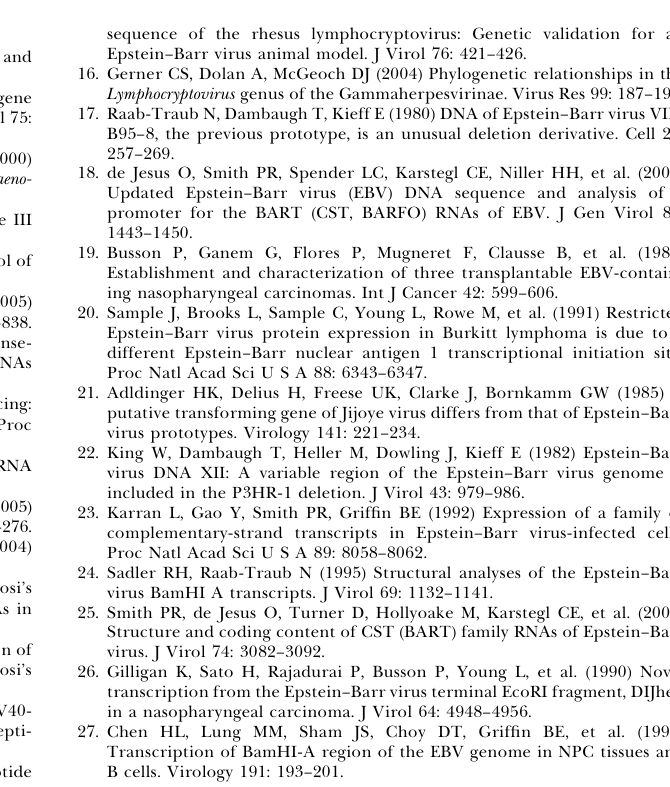
Figure S2. Northern Analysis of EBV miRNA Expression This analysis was performed as described in Figure 2, using total RNA samples derived from the indicated EBV-infected cell lines. U6 was used as a loading control. In the case of miR-BHRF1–2, we present a larger panel that shows both the mature 23-nt miRNA and the approximately 59-nt pre-miRNA. Figure S3. A Single Nucleotide Mutation May Disrupt miR-BHRF1–1 Processing in Jijoye Cells (A) Sequence comparison of the genomic region flanking the mature miR-BHRF1–1 sequence in the type II EBV present in Jijoye cells with the wild-type type I EBV sequence [18]. Two single nucleotide changes and the mature miR-BHRF1–1 sequences are highlighted in blue. (B) One of these single nucleotide changes is predicted to disrupt the base-pairing of the stem of the primary miR-BHRF1–1 precursor, as indicated. Figure S4. Immunofluorescent Detection of the EBV Zebra Protein Daudi and MUTU I cells were either cultured as normal or induced with TPA (30 ng/ml final concentration) and n-butyrate (300 ng/ml final concentration) for 48 h. At this stage, the cells were either used for RNA analysis (see Figure 3) or fixed and stained using a mouse monoclonal anti-Zebra antibody (Argene Inc., North Massapequa, New York, United States) followed by a TRITC- conjugated donkey antimouse secondary antibody. Cells were also stained with DAPI. In each case, we show a phase image (upper left), DAPI fluorescence (upper right), TRITC fluorescence (lower left), and superimposed DAPI and TRITC fluorescence (lower right). Quantitation of the number of TRITC-positive cells showed that uninduced Daudi were approximately 1.7% Zebra-positive, induced Daudi approximately 19.4% Zebra-positive, uninduced MUTU I less than 0.5% Zebra-positive, and induced MUTU I approximately 54% Zebra-positive.